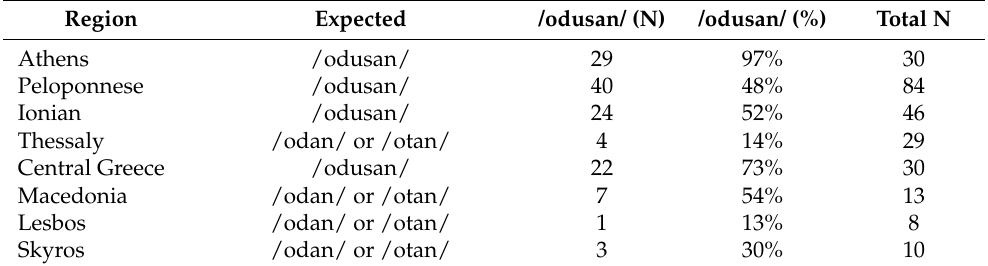
Table 7. Distribution of the 3rd plural mediopassive imperfective past by region of origin (N = 250). Region Expected /odusan/ (N) /odusan/ (%) Total N Athens /odusan/ 29 97% 30 Peloponnese /odusan/ 40 48% 84 Ionian /odusan/ 24 52% 46 Thessaly /odan/ or /otan/ 4 14% 29 Central Greece /odusan/ 22 73% 30 Macedonia /odan/ or /otan/ 7 54% 13 Lesbos /odan/ or /otan/ 1 13% 8 Skyros /odan/ or /otan/ 3 30%